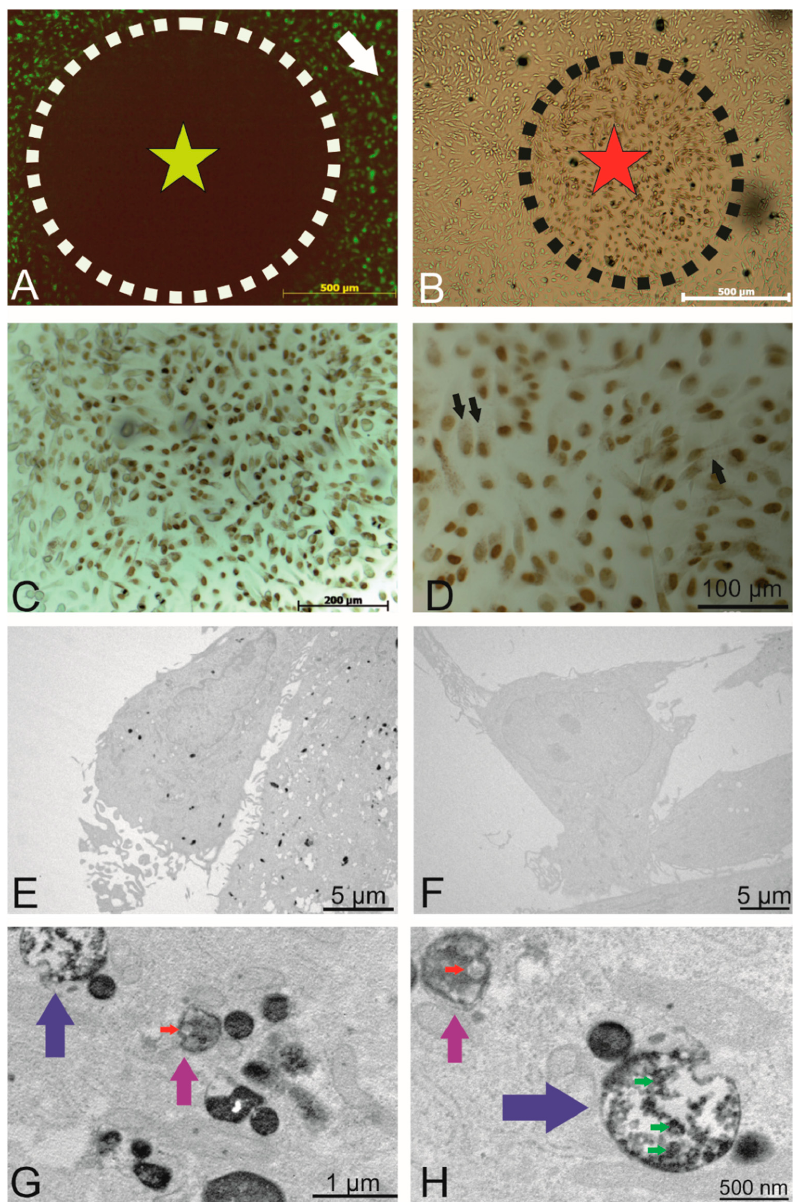
Figure 4. Intracellular localization of the internalized PKH-labelled small EVs. ( A ) Circled area shows the area of fluorophore (label of the small EVs) following photobleaching (outside this circle, there was no light exposure). ( B ) DAB precipitate was observed in areas of photobleaching. ( C ) Photobleached area where a precipitate was observed. ( D ) Depiction of the photobleached areas where the nucleus was visible under different magnifications (Draq5 that was photoconverted), and the fine intracellular precipitate dots represent the PKH-labelled small EVs. ( E ) TEM micrographs showing the DAB precipitate representing labelled small EVs as electron dense dots. ( F ) Representative non-photobleached areas where no precipitate could be observed (negative control). ( G ) Higher magnification of the TEM micrographs. Labelled small EVs are visible within endosomes (magenta arrows) and multivesicular endosomes (blue arrows). ( H ) A second representative micrograph showing multivesicular endosomes (blue, magenta arrows) containing small EVs. The red arrow indicates DAB-negative small EVs (size of about 100 nm). Green arrows point to DAB-positive vesicles of similar